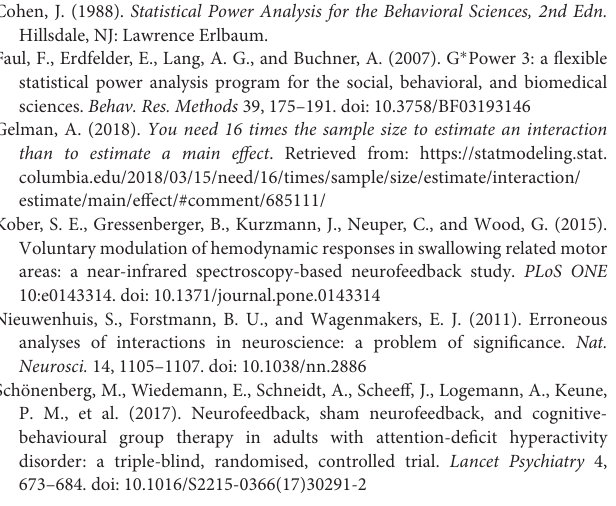
Table 5. Sensitivity and statistical power for reported